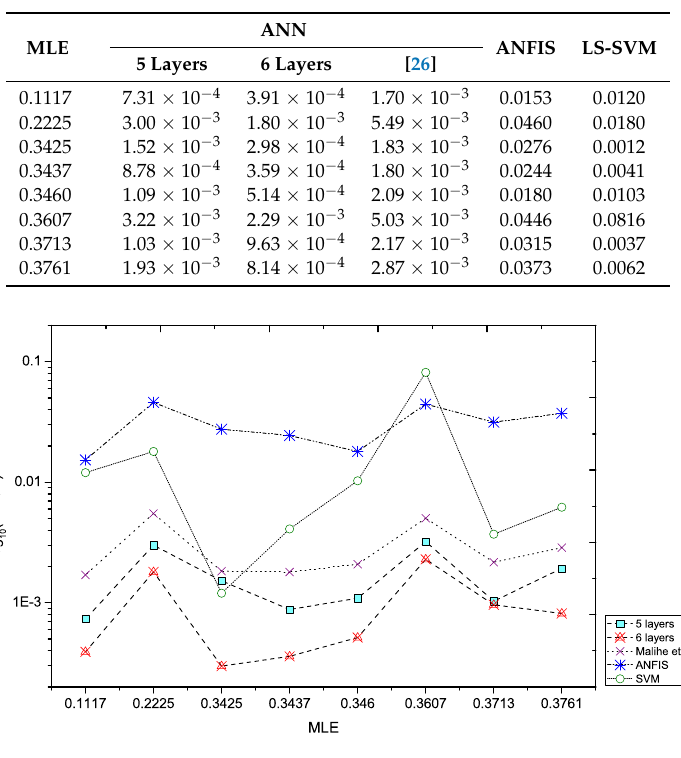
Figure 5. Comparing the RMSE of the MLPs from Table 3, ANFIS and SVM for the prediction of the chaotic time series listed in Table 1 and achieving a six steps ahead prediction horizon